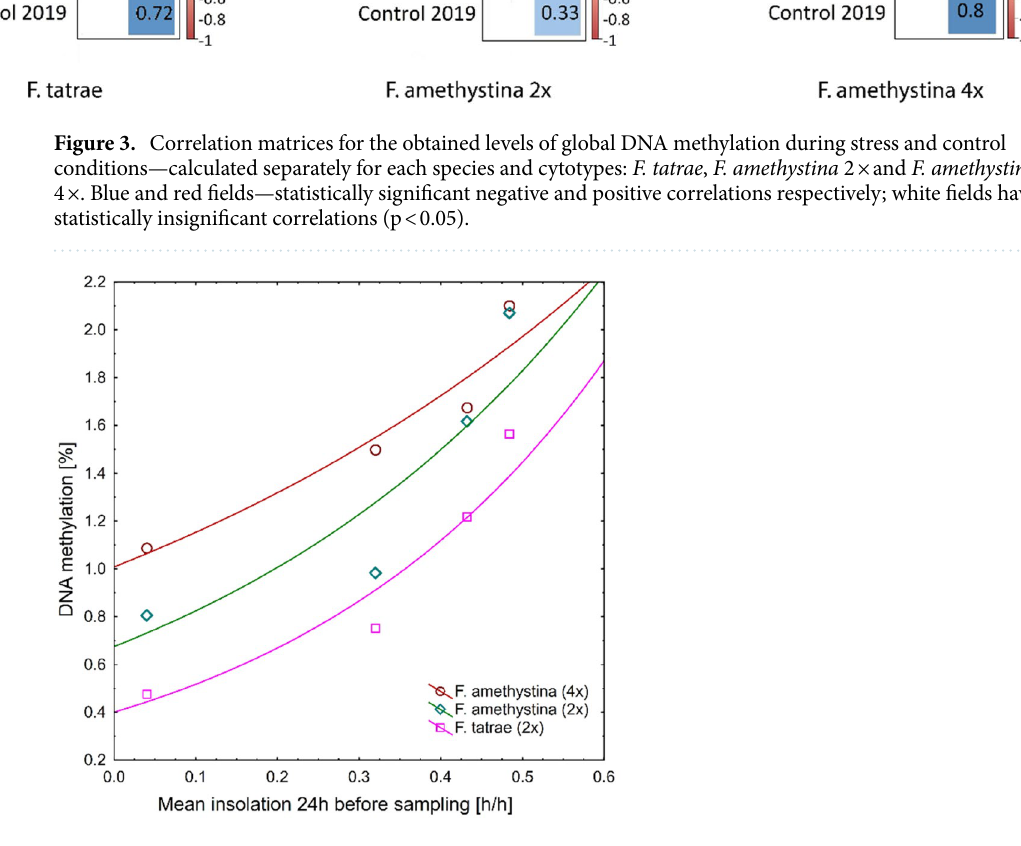
Figure 4. The exponential relationship between mean global DNA methylation level and mean insolation 24 h before material sampling, according to species and ploidy level, in the common garden experiment with F. amethystina and F. tatrae . Global DNA methylation values are means for all studied specimens in each group and at each sampling